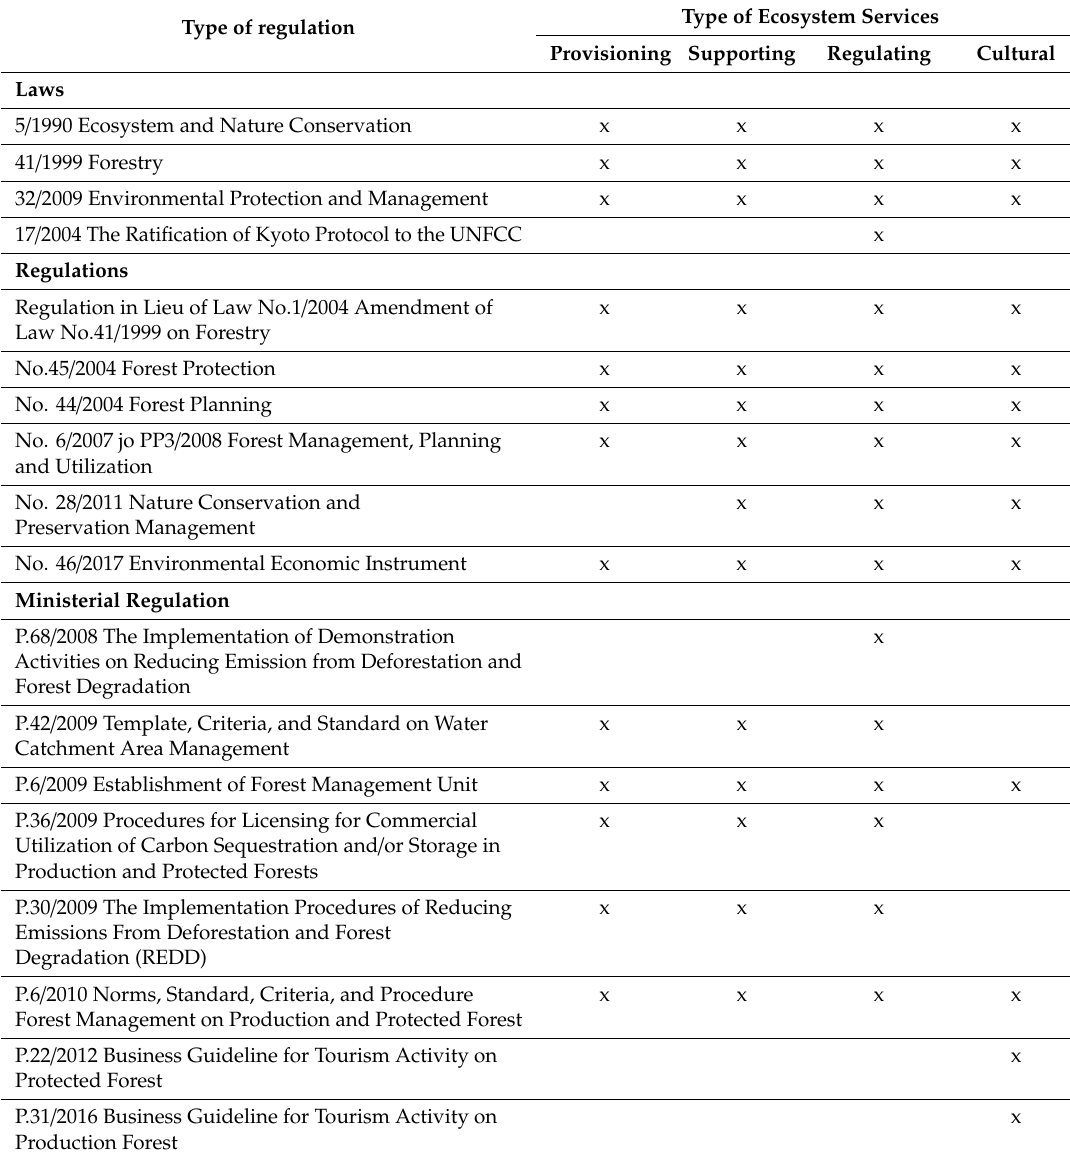
Table 1. Indonesian state regulations addressing ecosystem